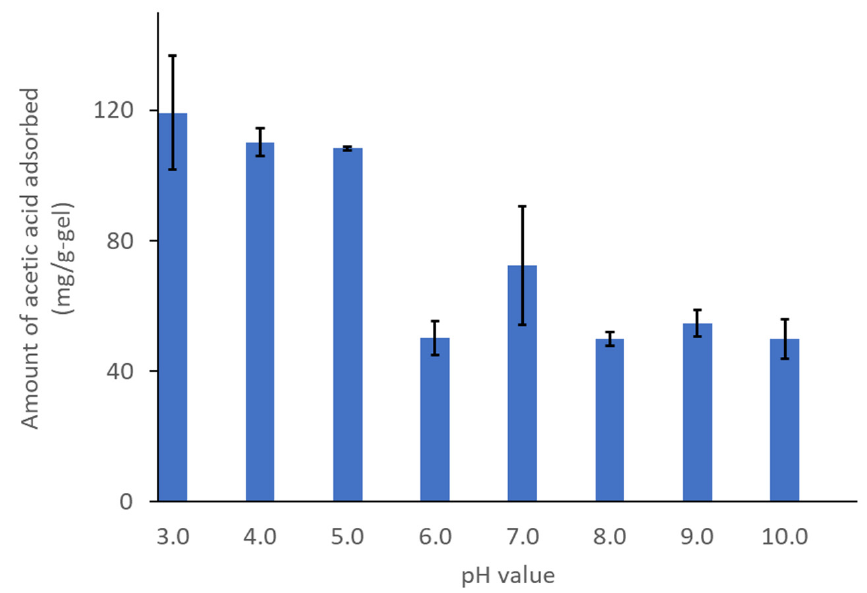
Figure 5. Comparison of the adsorption in acetic acid (10 g/L) at various pH.